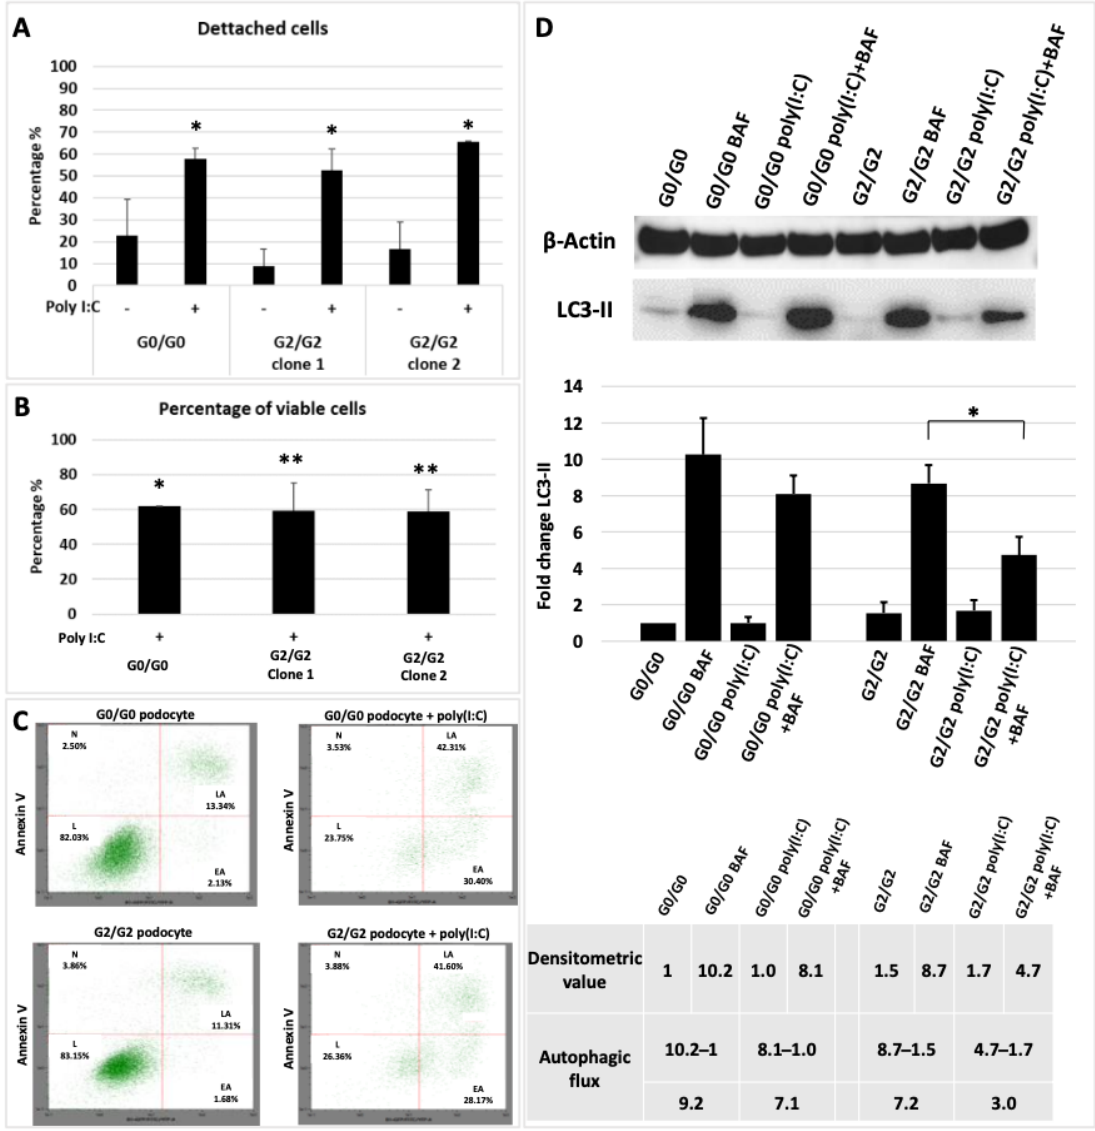
Figure 3. APOL1-induced cell toxicity. ( A ) Proportion of detached APOL1 G0/G0 and APOL1 G2/G2 podocytes by the total number of cells before and after 24 h of incubation with poly(I:C). Each bar represents mean ± SD of three independent experiments, performed in technical triplicates. * p < 0.05. ( B ) The WST-1 assay in two clones of G2/G2 and one G0/G0